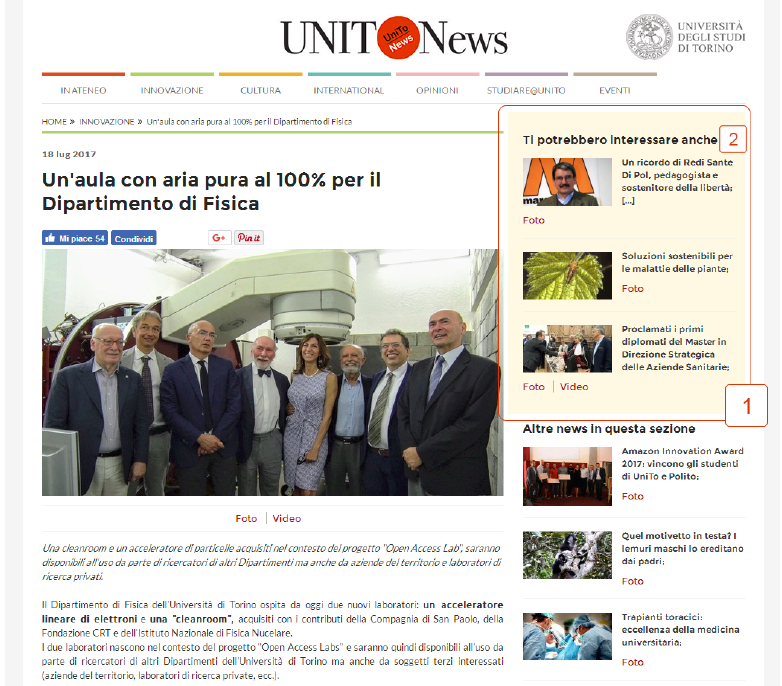
Figure 2. News detail page with a set of recommended news (1). Notice the yellow box used to provide visual accent and the persuasive sentence introducing recommendations